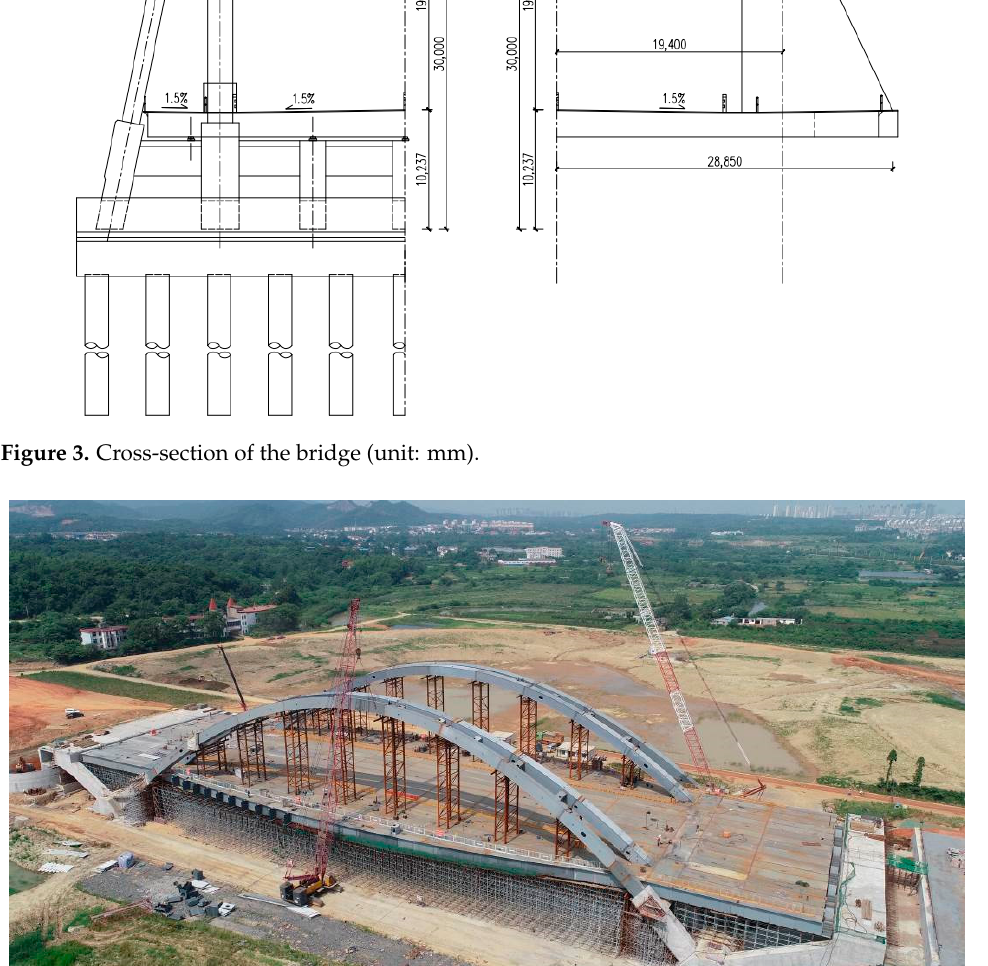
Figure 4. Steel box girder and arch ring construction completed.